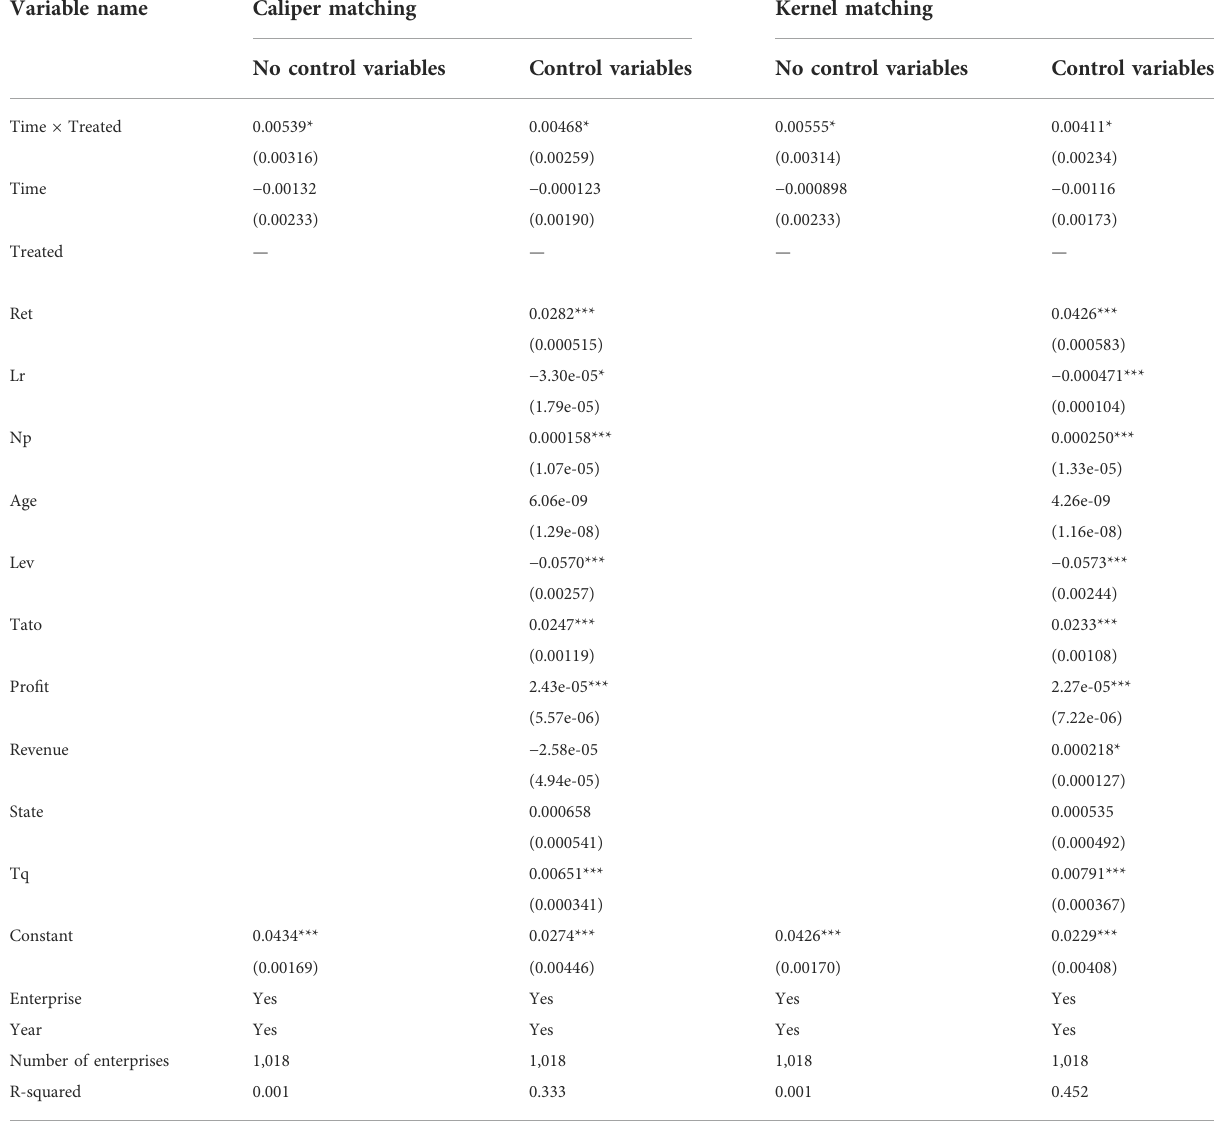
TABLE 5 Caliper matching, kernel matching regression